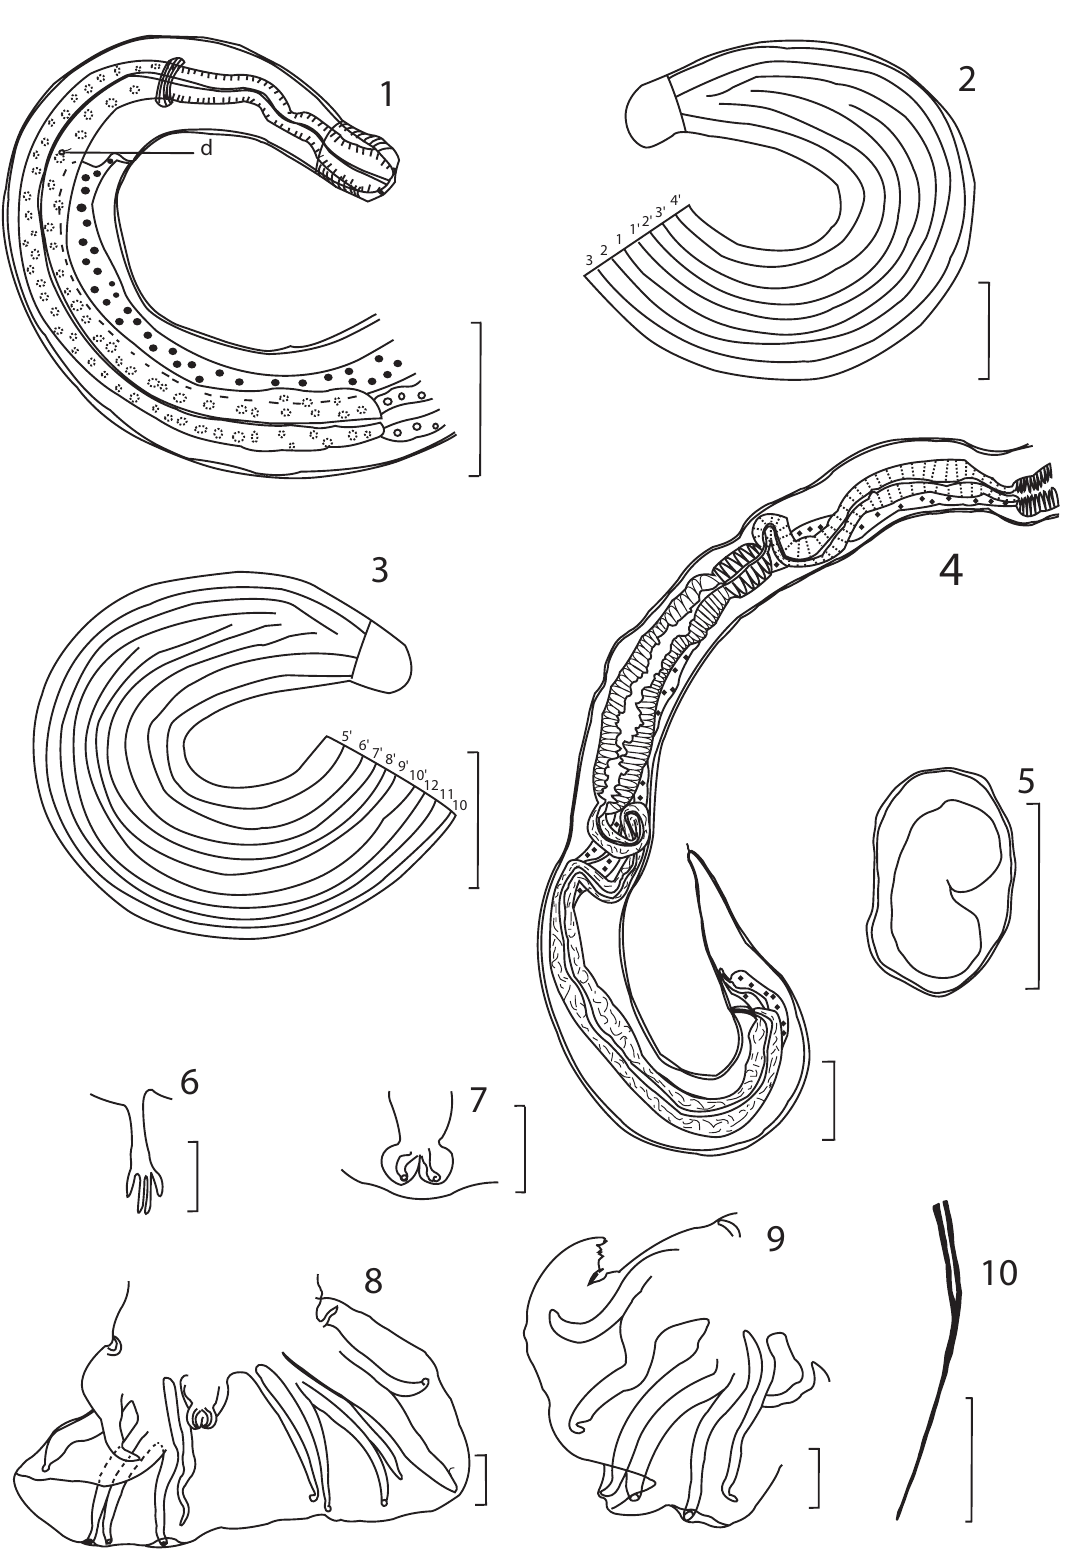
Figs. 1-10. – Heligmosomoides craigi n. sp . from Microtus limnophilus : 1, male, anterior extremity, right lateral view; 2-5, female, 2, 3, ari- sing of the cuticular ridges, 2, left lateral view 3, right lateral view, 4, posterior extremity, right lateral view, 5, embryonated egg, 6-10 male, 6, dorsal ray, dorsal view, 7, genital cone, ventral view, 8, 9, caudal bursa, 8, with right lobe folded, ventral view, 9, with right lateral lobe open, ventral view, 10, distal tip of one spicule. Scale bars: Figs 1-4: 100 µm; Fig. 5: 50 µm; Figs 6-9: 30 µm; Fig. 10: 20 µm. Figs 8 and 9 from two males. Abbreviation: d: